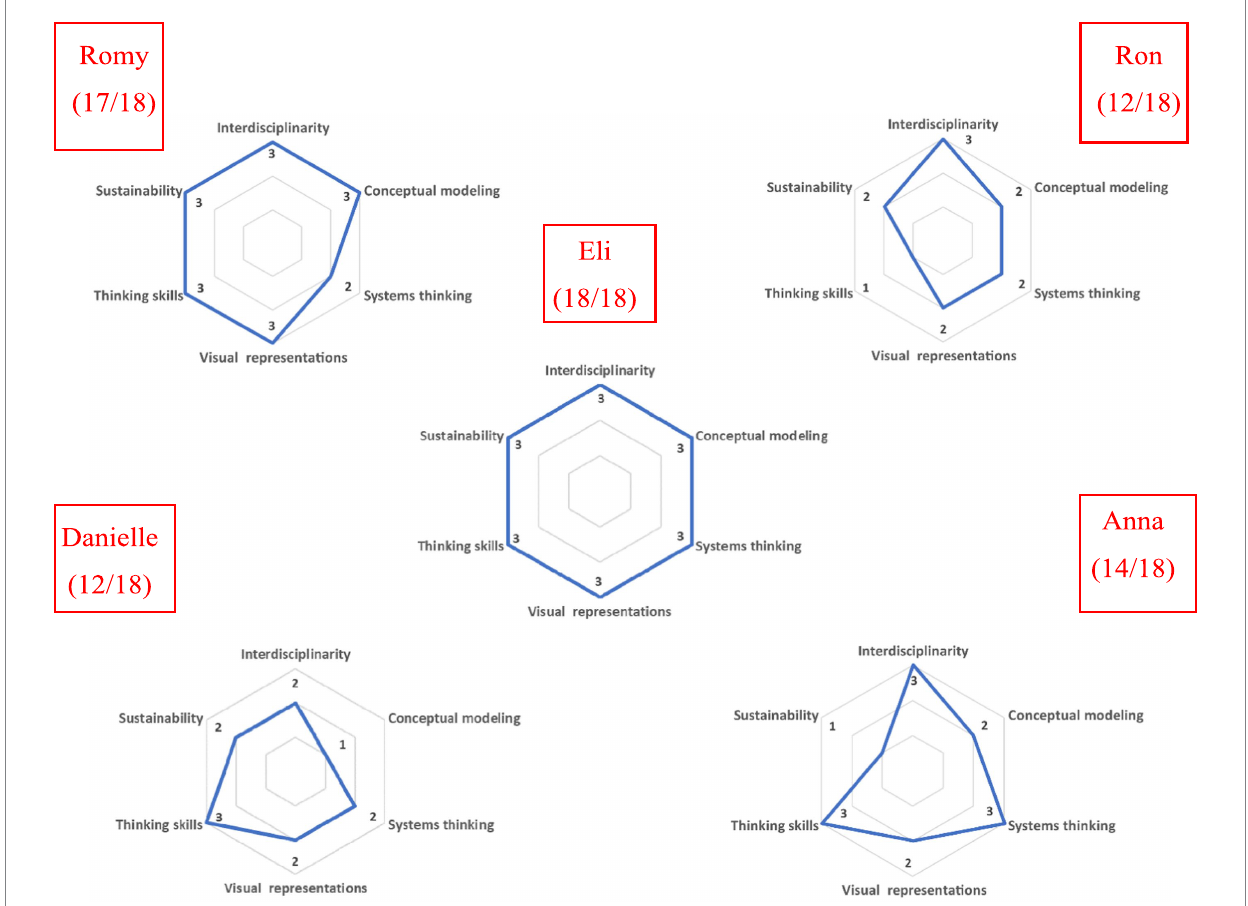
FIGURE 7 Spider charts of the five teacher assignments showing for each teacher the total score and scores of each of the six